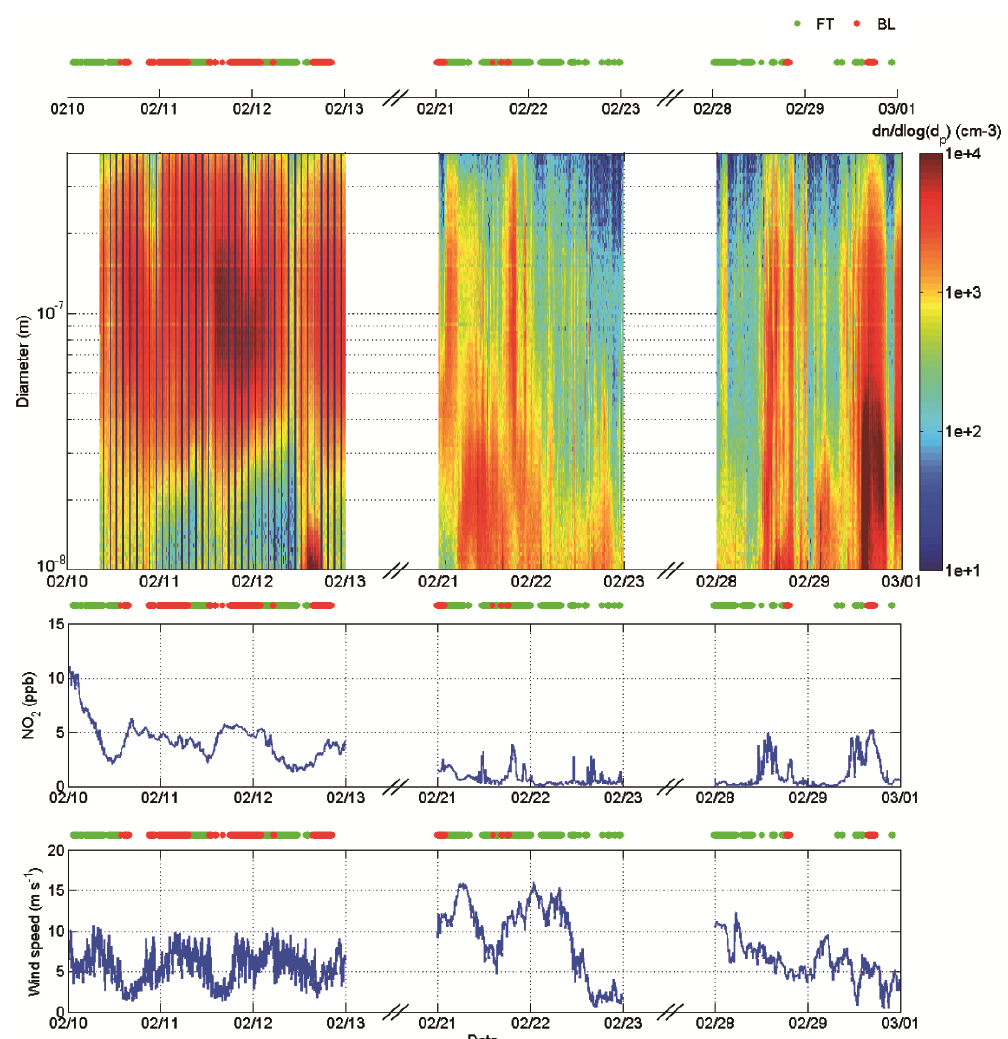
Figure 2. SMPS particle size distribution, NO 2 concentrations and wind speed measurement used as additional information to distinguish between the BL and the